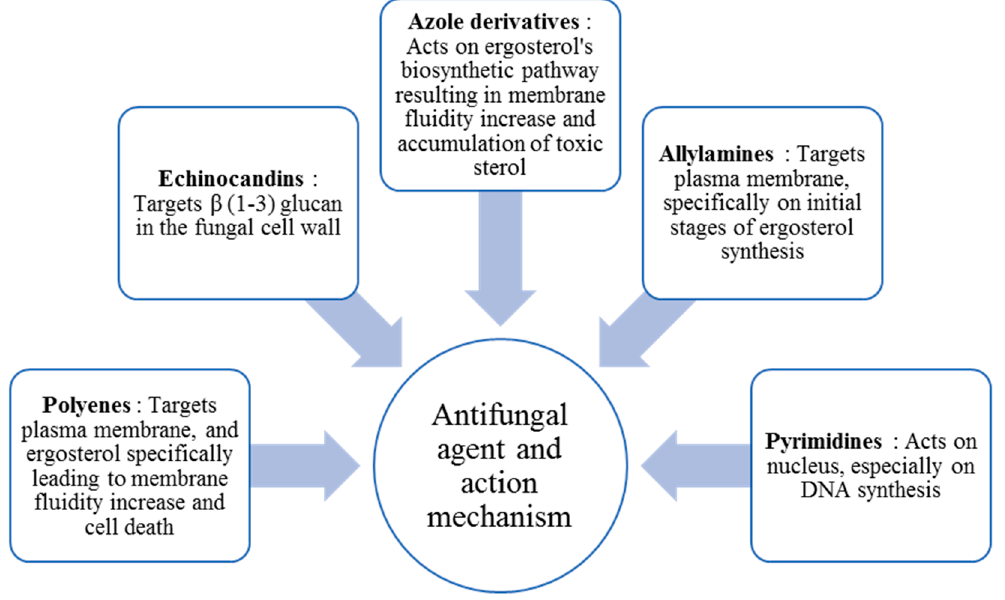
Figure 1. Conventional antifungal agents and their mechanisms of action (Adapted from [19]).